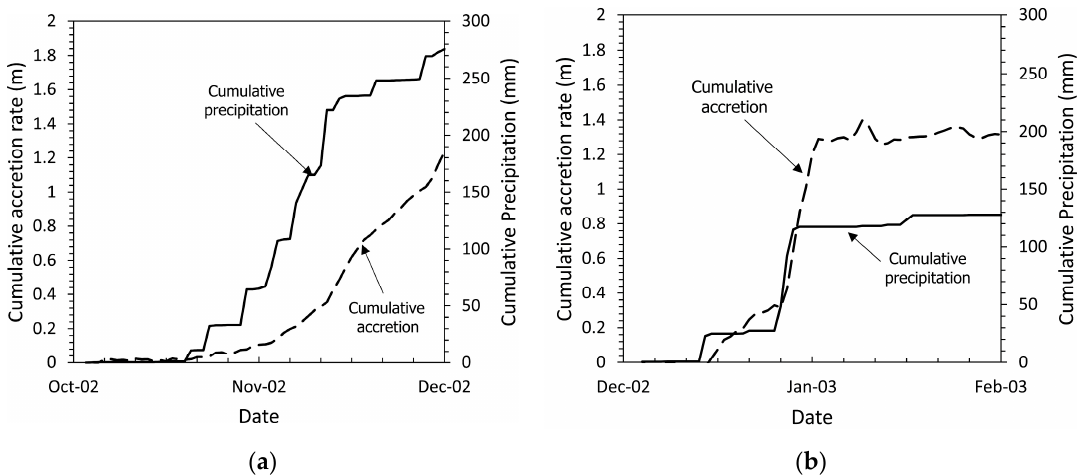
Figure 6. Cumulative precipitation (mm) and cumulative accretion (m) determined with Equation (7): ( a ) event #1 ( b ) event #2.